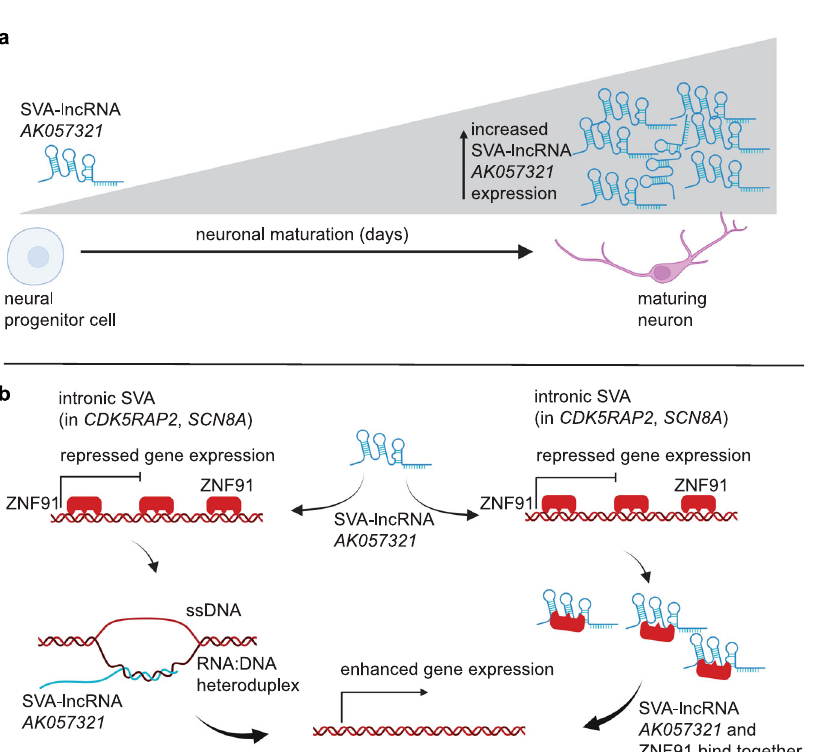
Fig. 7 SVA-lncRNA AK057321 forms an RNA:DNA heteroduplex with intronic SVA sequences in CHAF1B , CDK5RAP2 , and SCN8A genes and binds transcription factor ZNF91. a Schematic showing two approaches to isolate genomic DNA associated with SVA-lncRNA AK057321 . b RT-qPCR of human CHAF1B mRNA levels in 3T3 clones stably transfected with CHAF1B BAC DNA or CHAF1B BAC del-SVA DNA and infected SVA-lncRNA AK057321 lentivirus or control virus. n = 3 biological replicates for clone 1, n = 6 biological replicates clones 2 – 3. Unpaired Student ’ s t test. c qPCR for CHAF1B genomic DNA from eluted from RNA:DNA heteroduplex antibody or control antibody pulldowns in CHAF1B BAC or CHAF1B SVA-del BAC 3T3 clones transfected with AK057321 cDNA or control. n = 4 biological replicates. d qPCR for CHAF1B genomic DNA in eluted RNA:DNA complexes isolated by streptavidin pulldowns from CHAF1B BAC or CHAF1B SVA-del BAC 3T3 clones transfected with 5 ’ -apatamer- AK057321 , untagged AK057321 or control. n = 4 biological replicates. e qPCR for CHAF1B genomic DNA in eluted RNA:DNA complexes from streptavidin pulldowns performed in NTera-2 cells transfected with 5 ’ -apatamer- AK057321 or untagged AK057321 n = 8 biological replicates. c – e Results are shown as folds enrichment compared to control. f , g qPCR for CDK5RAP2 or SCN8A genomic DNA from eluted RNA:DNA heteroduplex antibody and control antibody pulldowns in NTera-2 cells co-transfected with AK057321 cDNA with or without Crispr/Cas9 sgRNAs to delete the SVA within CDK5RAP2 ( f ) or SCN8A ( g ). n = 6 biological replicates each. h Approach for co-precipitation of myc-tagged ZNF91 with SVA-lncRNA AK057321 (Created with Biorender.com). i RT-qPCR for AK057321 RNA levels in eluted anti-myc vs. control antibody pulldowns performed in 293T cells co-transfected with myc-tagged ZNF91 and either AK057321 cDNA or control vector. Results are graphed as folds enrichment of AK057321 compared to control antibody pulldown. n = 3 biological replicates. Data represent the mean ± SEM. **** p < 0.0001,